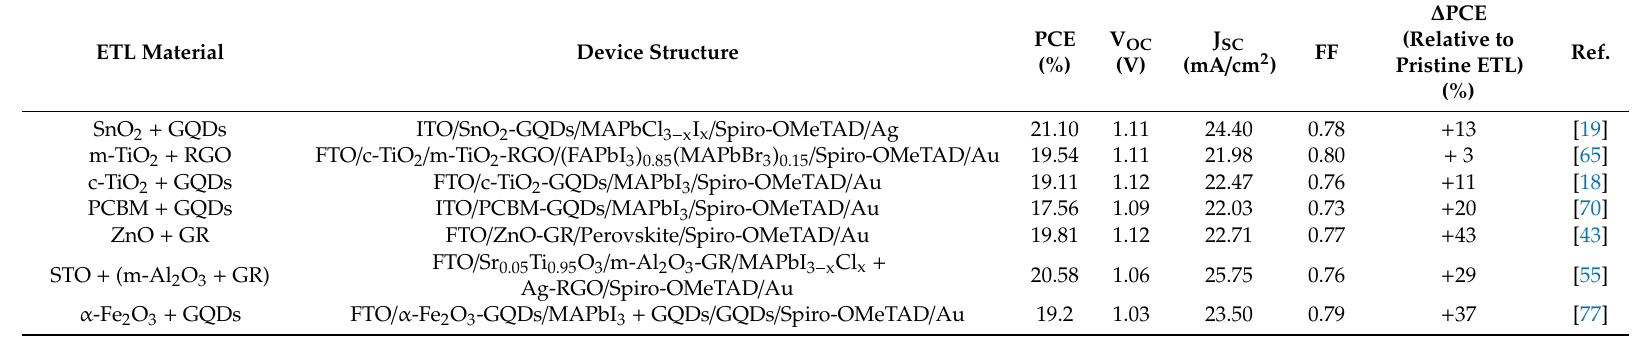
Table 1. Summary of reports of PSCs with the highest PCEs containing ETLs with GBMs.